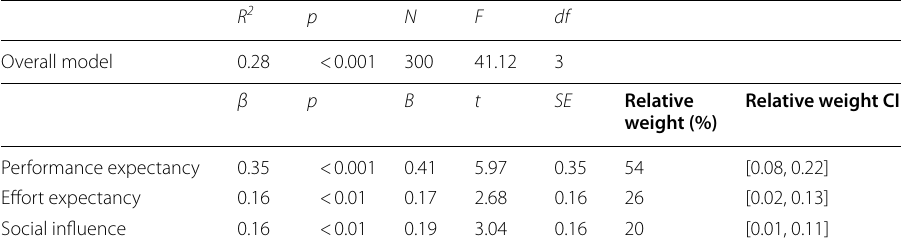
Table 2 Summary of the multiple regression model predicting behavioral intention to Use VR R 2